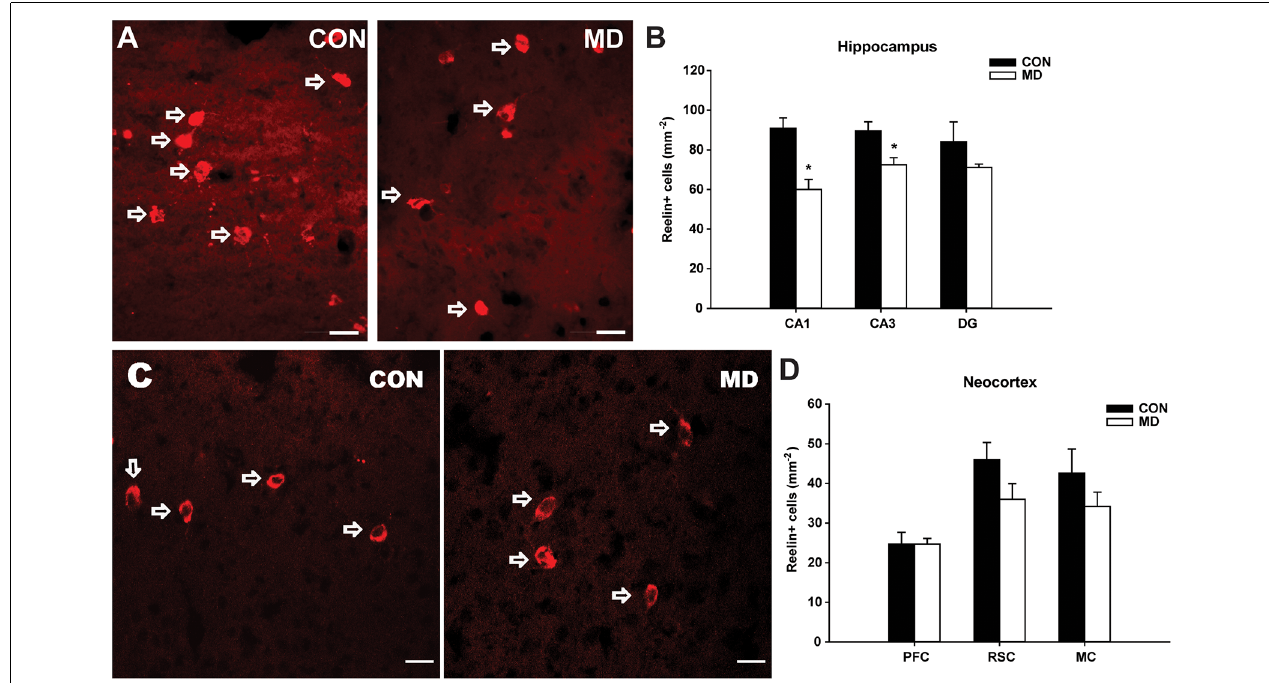
FIGURE 4 | Reelin-expressing interneurons. (A) Representative images of immunofluorescence staining for reelin in the CA3 region of the hippocampus of a control (CON, left panel) and an MD rat at P60. (B) Shown are mean values + standard error of the mean (SEM) for profile densities (number of immunopositive cells per area) of reelin+ neurons in the hippocampus of MD and control rats (* p < 0.05, t -test, n = 6 animals per group). (C) Representative images of immunofluorescence staining for reelin in the retrosplenial cortex of a control (CON, left panel) and MD (right panel) rat at P60. (D) Shown are mean values + standard error of the mean (SEM) for profile densities (number of immunopositive cells per area) of reelin+ neurons in the neocortex of MD and CON rats ( p > 0.05, t -test, n = 6 animals per group). Scale bars: 20 µ m.